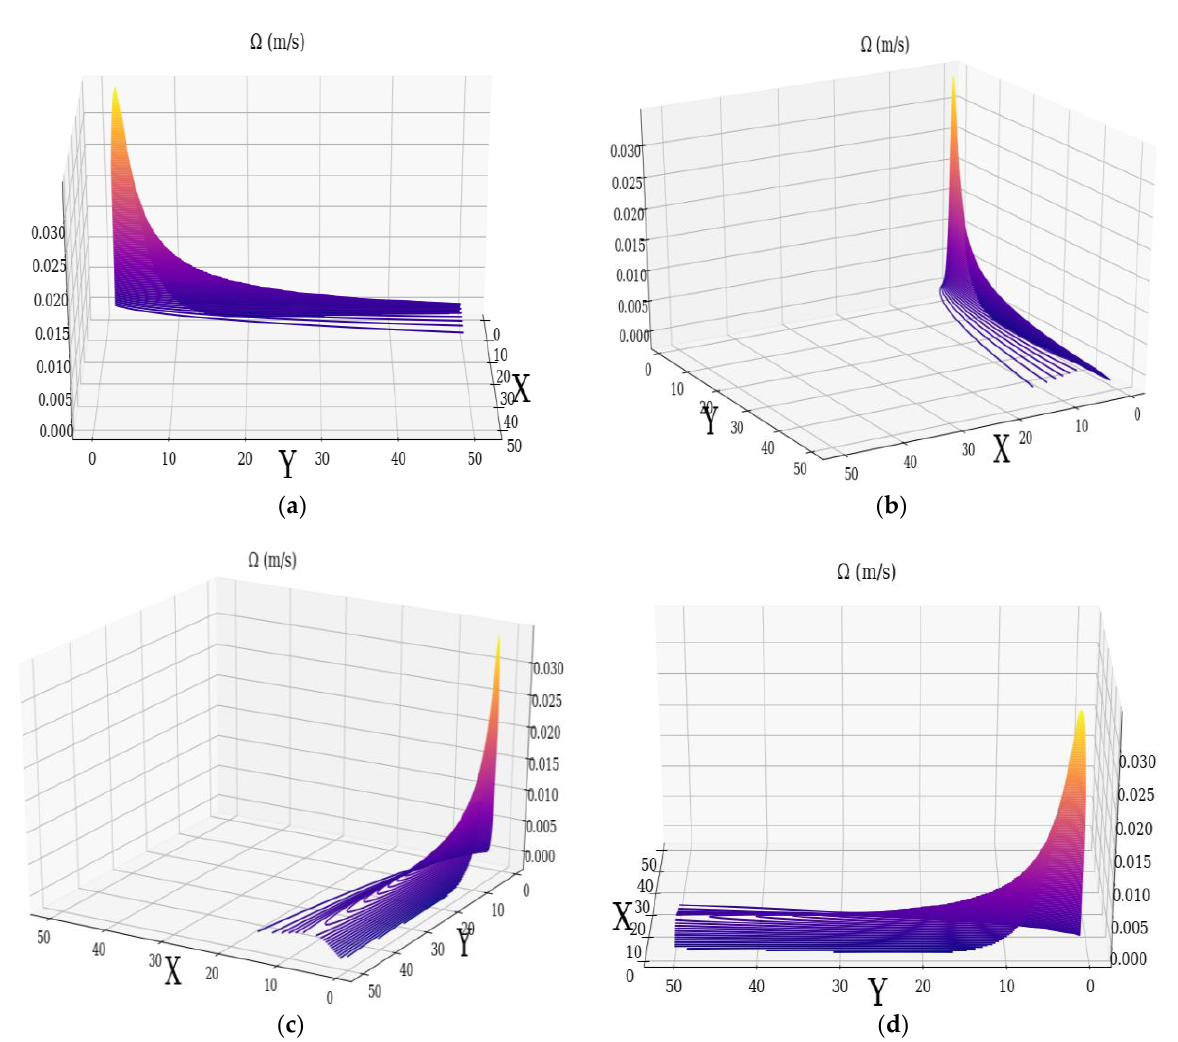
Figure 4. Approximate minimal vortex Ω of real atmospheric multifractal: ( a ) 𝜃 = 0° ,( b ) 𝜃 = 60° , ( c ) 𝜃 = 120° , ( d ) 𝜃 = 180° .